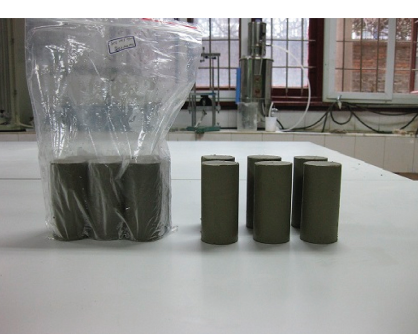
Figure 2: Sampling site [30]. Table 1: Basic physical properties of the dredged material.